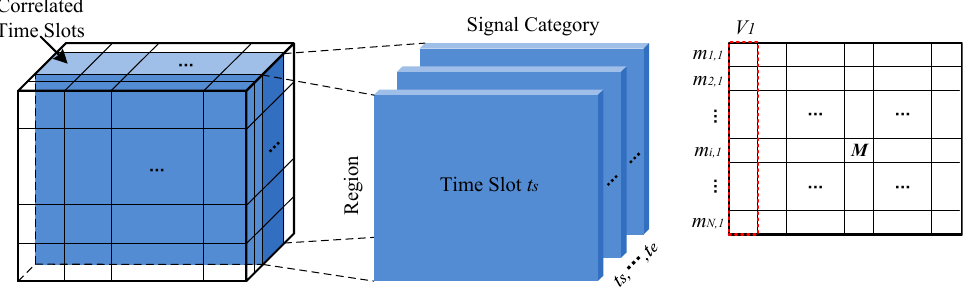
Figure 5. Correlated time slots combination.